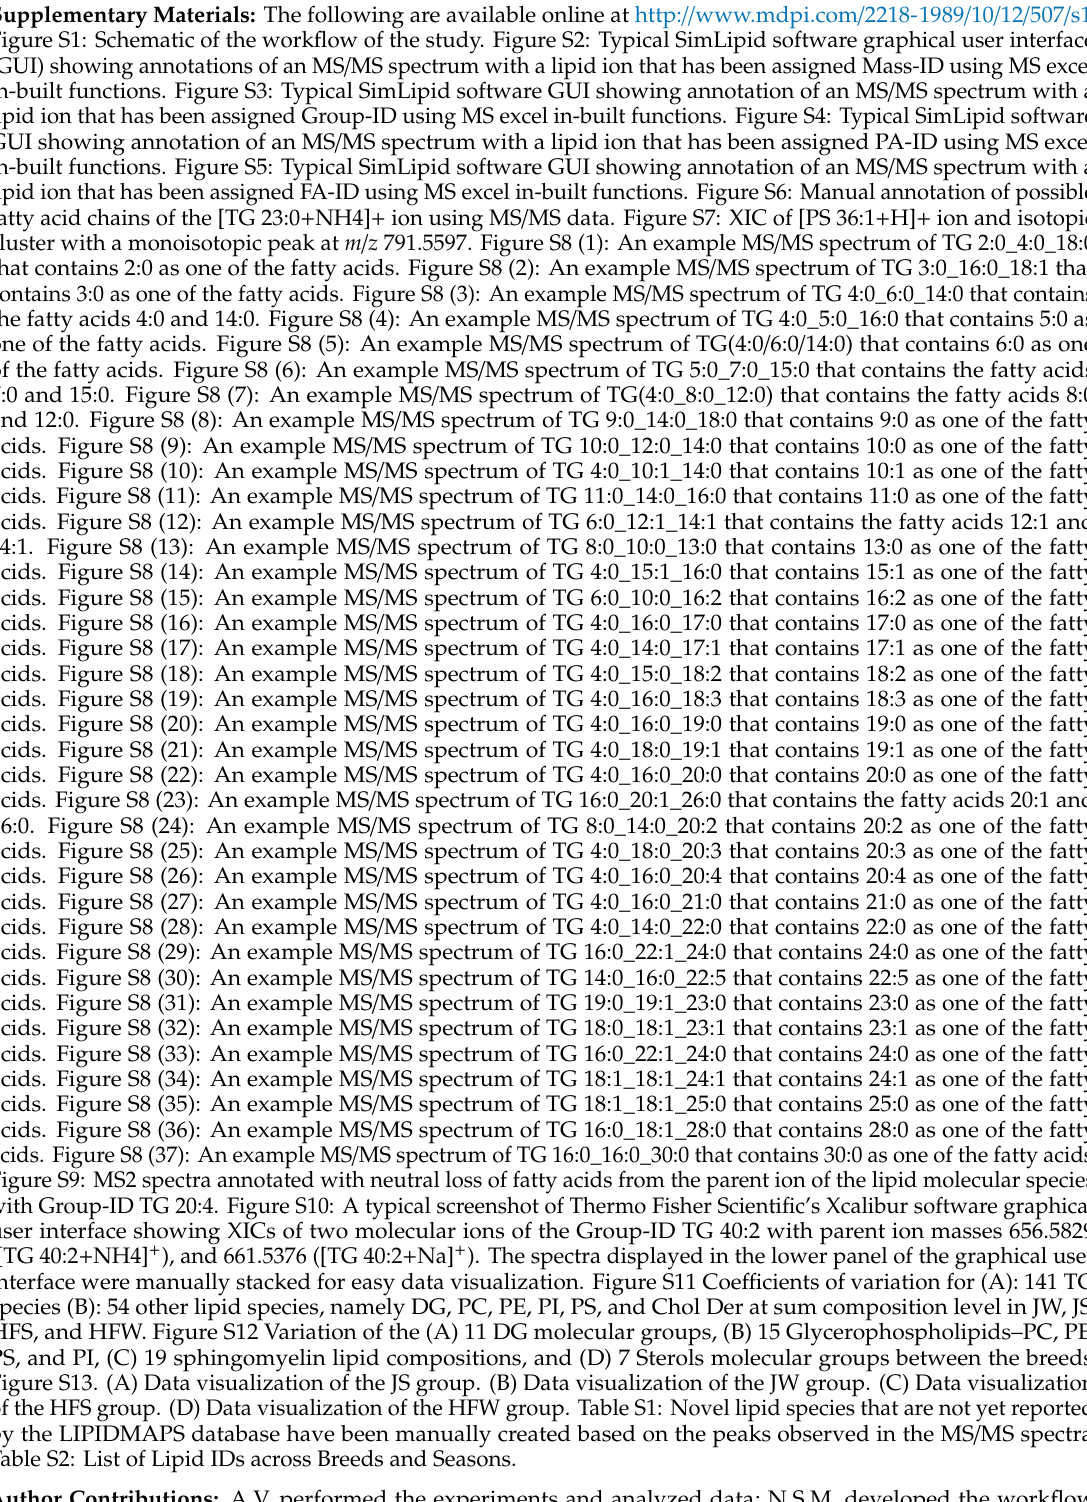
Table S2: List of Lipid IDs across Breeds and